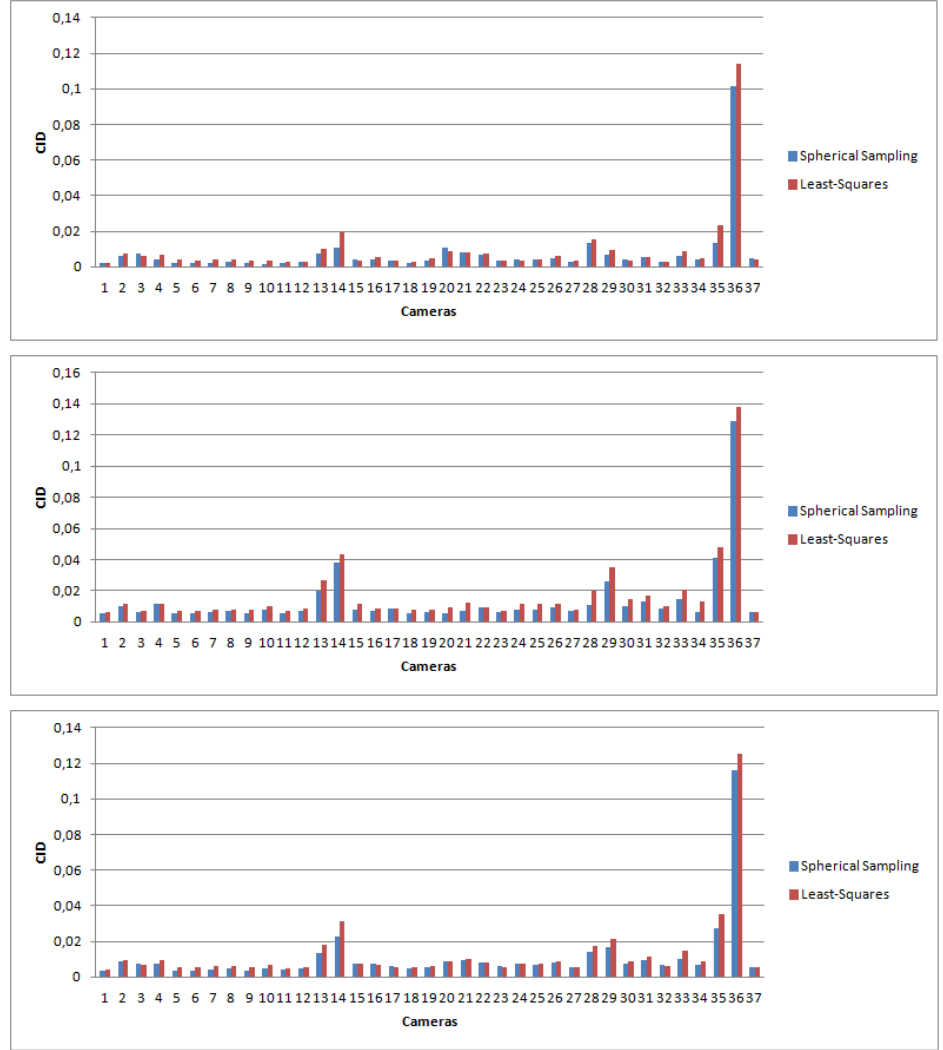
Figure 12. Color Image Difference (CID) error for the different cameras computed as the mean for the different images. In blue: CID error for spherical sampling; in red: error for the least-squares minimization. ( Top ) First dataset; ( middle ) second dataset; ( bottom ): third dataset.